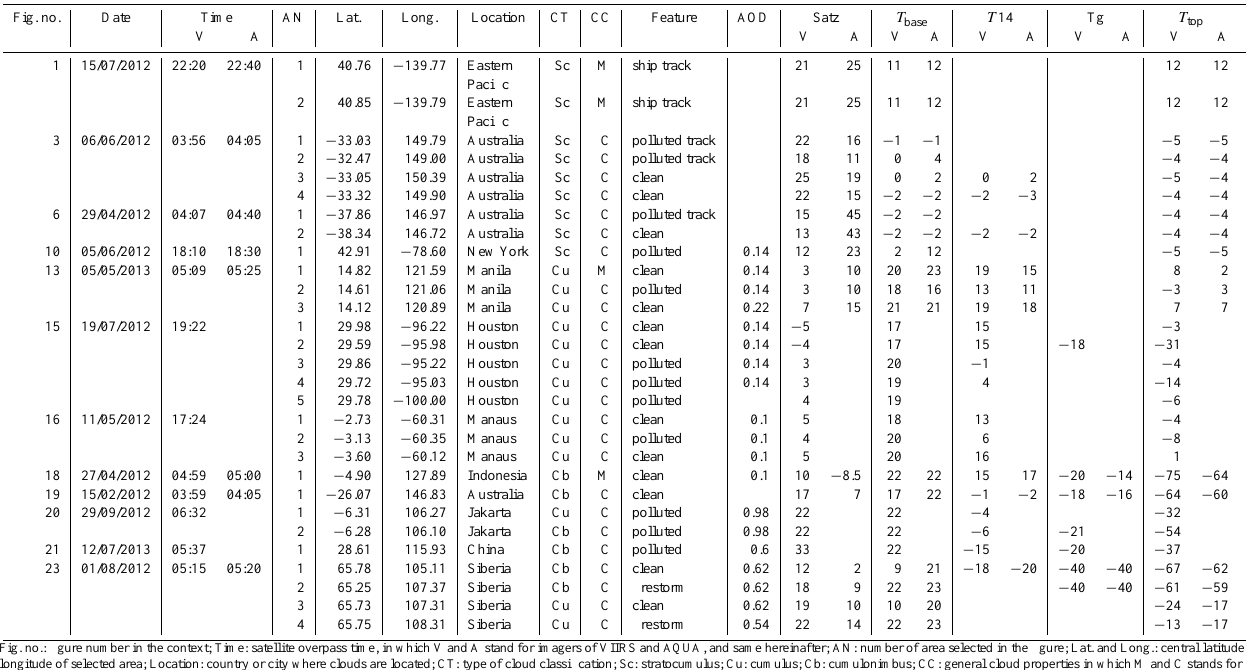
Table 2. Cloud samples in this study. Fig. no.